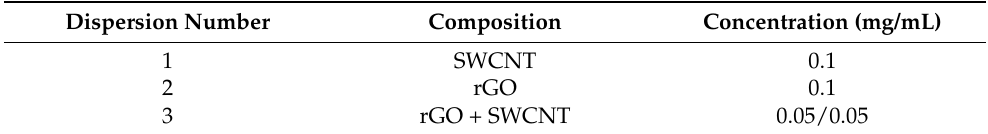
Table 1. Dispersions